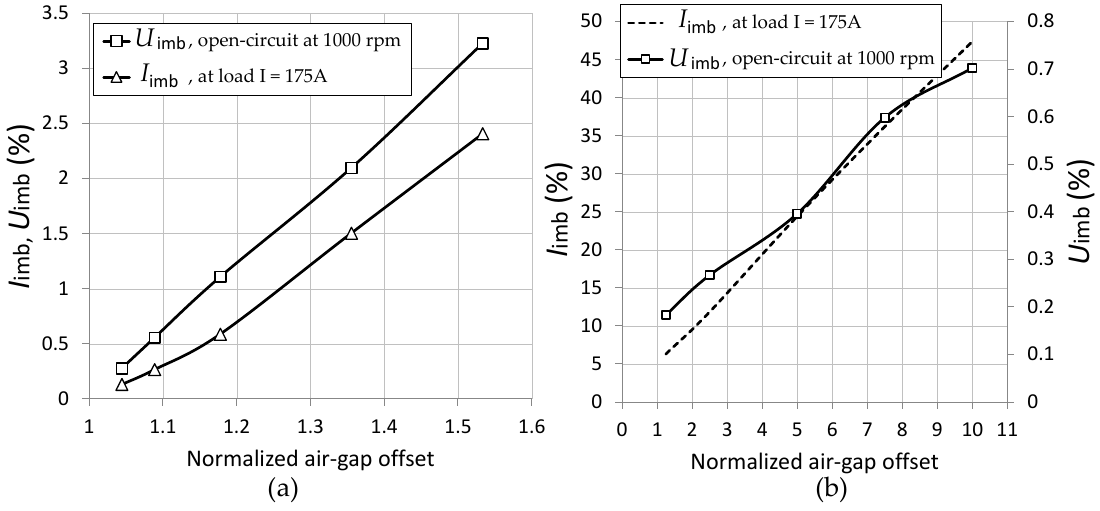
Figure 12. Current and back-EMF waveforms in different operating conditions with 10 electrical degrees of stator offset: ( a ) Full load; ( b ) open-circuit at 1000 rpm. Results related to stator-1 indicated by a solid line; to stator-2, by a dotted line.